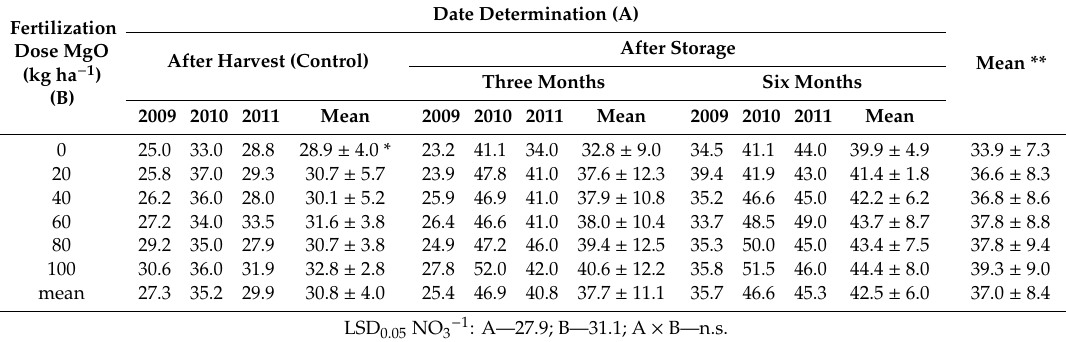
Table 5. The TGA content in potato tubers (mg kg − 1 FW) depending on Mg fertilization and date of